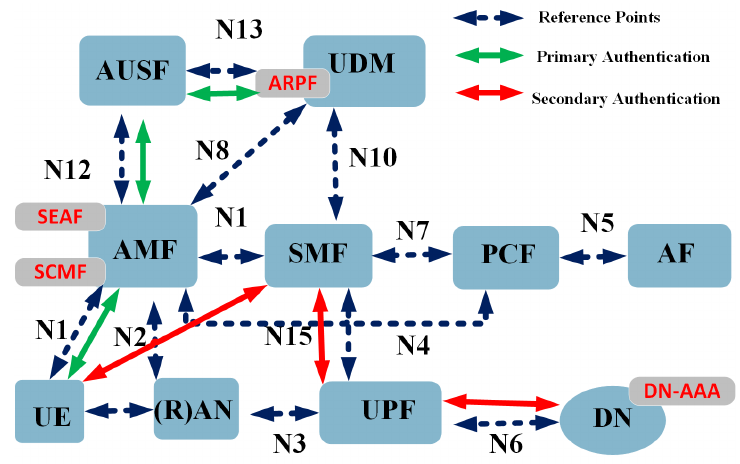
Figure 1. 5G security